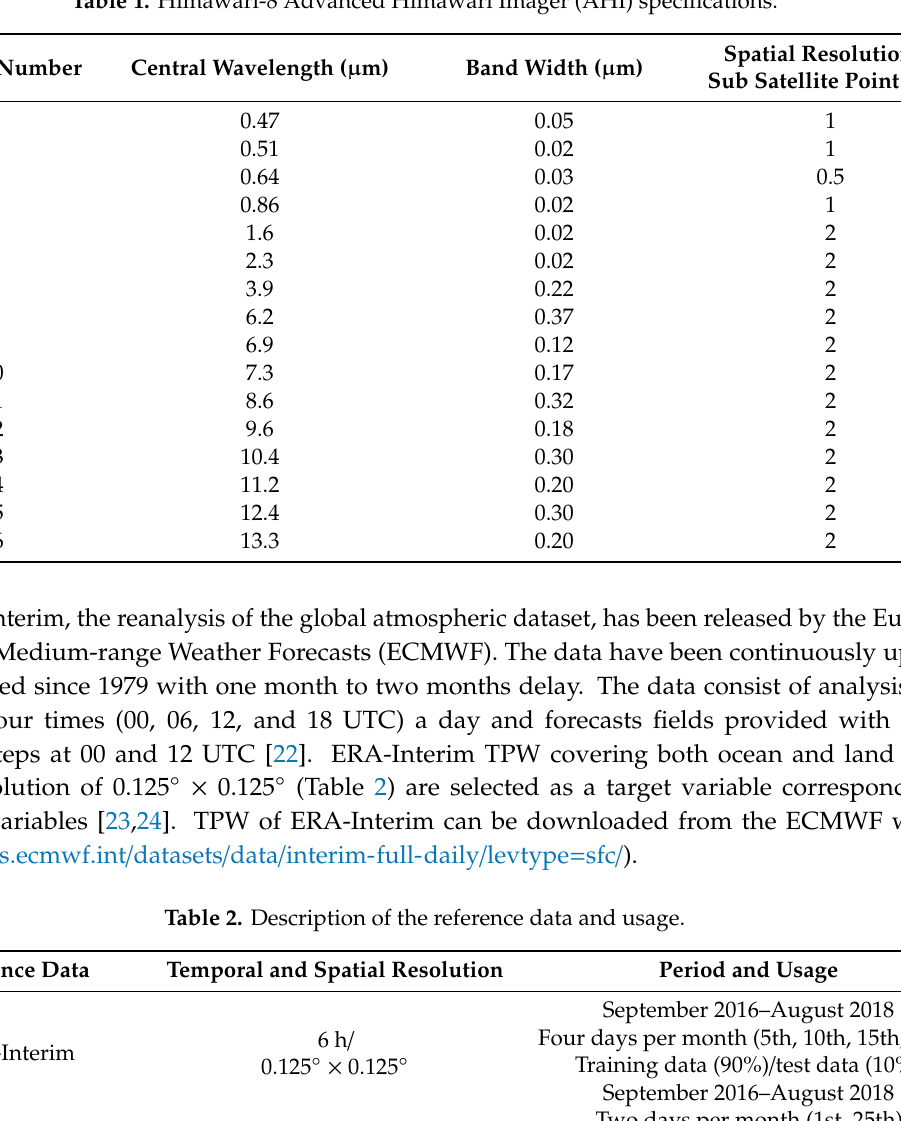
Table 1. Himawari-8 Advanced Himawari Imager (AHI) specifications.